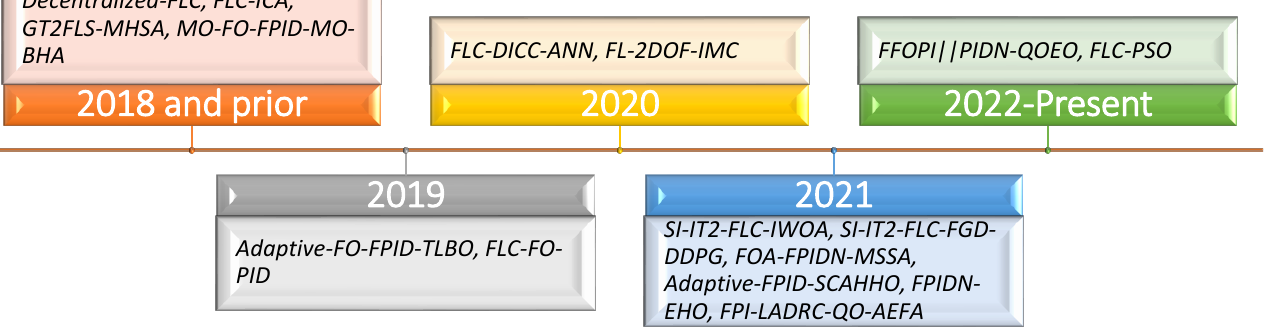
Figure 6 . Time order progression of fuzzy control variants as EVAS frequency contingency services.